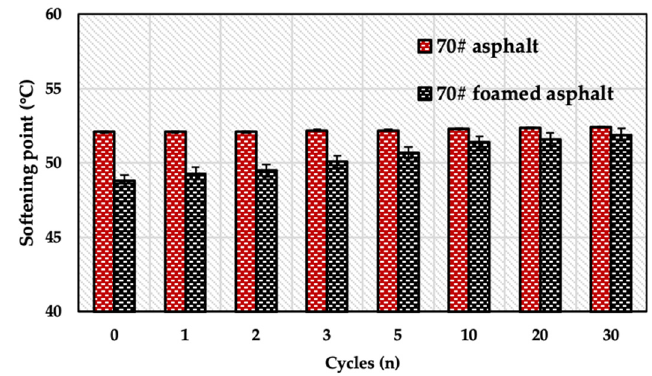
Figure 4. Softening point test results of samples with high-temperature evaporation cycles.